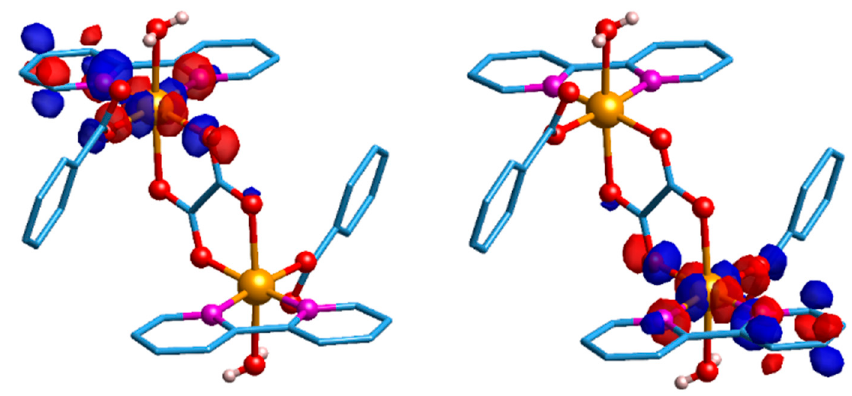
Figure 7. Graphic representation of the two empty broken symmetry (BS) magnetic orbitals for complex 1 (left panel, spin-up; right panel, spin-down). The electron density iso value was set to 0.04 e / (a 0 ) 3 . Light-blue: carbon; white: hydrogen; red: oxygen; orange: copper; pink: nitrogen.